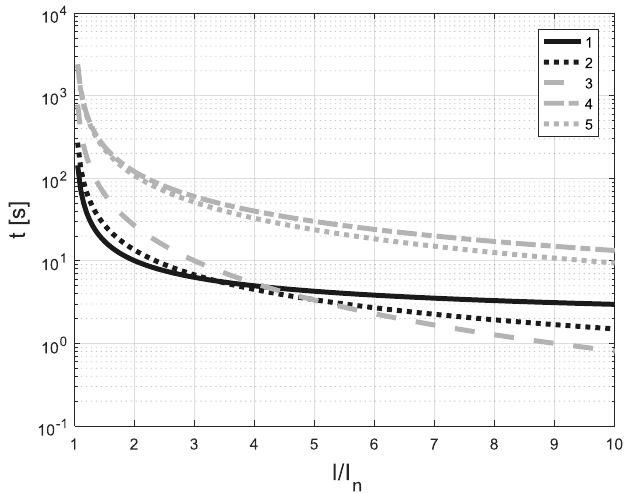
Figure 1. Time-current characteristics of overcurrent protections with characteristics consistent with European Standards [4] and Invertim [16]: 1—Standard Inverse, 2—Very Inverse, 3—Extremely Inverse, 4—Long Inverse,